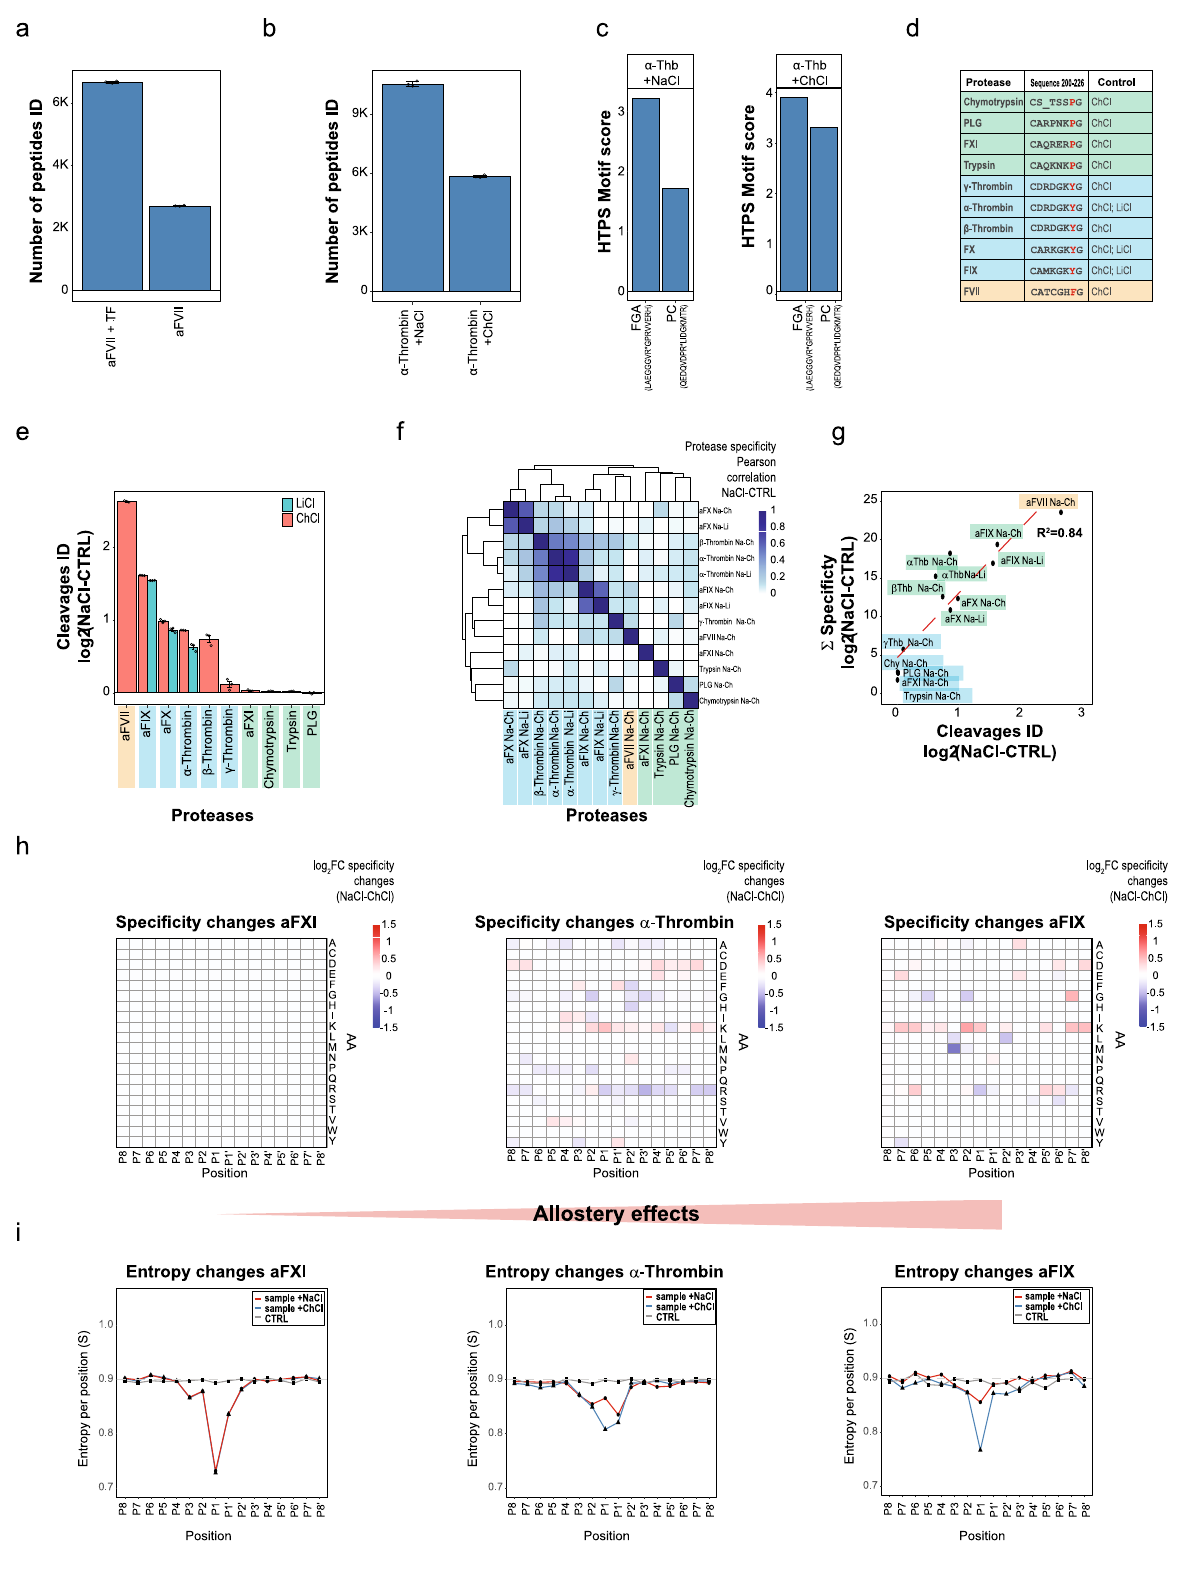
cannot be coordinated in the Na + binding site, Li + is too small to generate a productive allosteric effect. Before assaying the effect of Na + allostery on protease activity and speci fi city at 20 °C (at this conditions, α -Thrombin exists predominantly in Na + -bound or Na + -free form 63 ), we evaluated the effect of lower temperature on activity and speci fi city of Chymotrypsin and α -Thrombin.